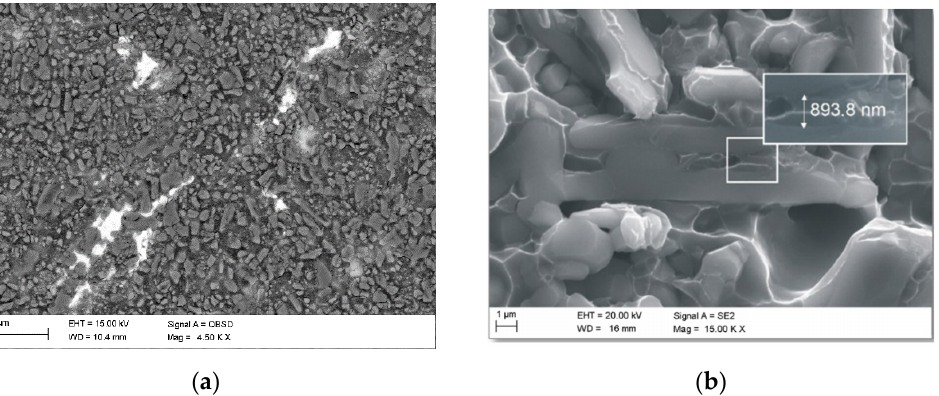
Figure 7. Microstructure ( a ) and fracture surface ( b ) of the infiltrated composites reinforced with porous ceramics sintered at 1600 °C.